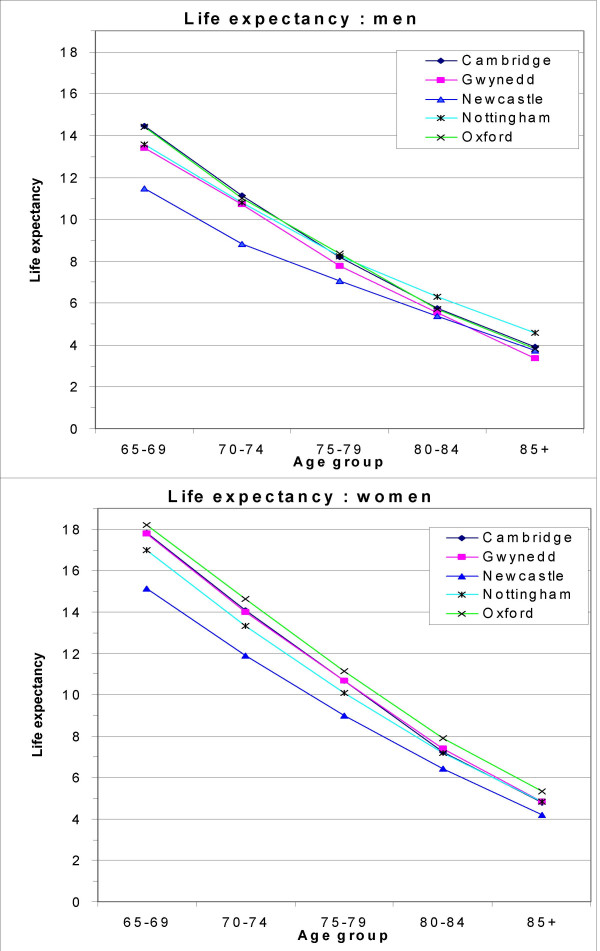
Life expectancy from age 65 years for men and women, by centre.